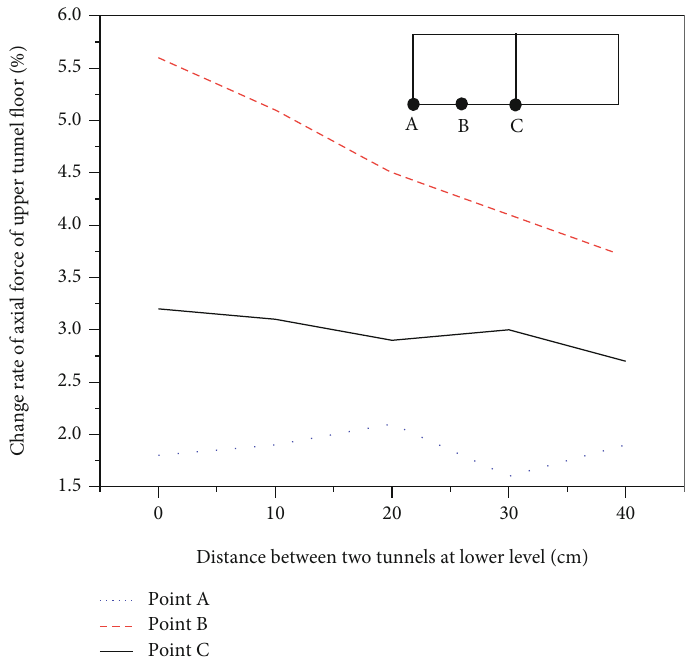
Figure 12: Change rate of axial force of upper fl oor under di ff erent spacings.